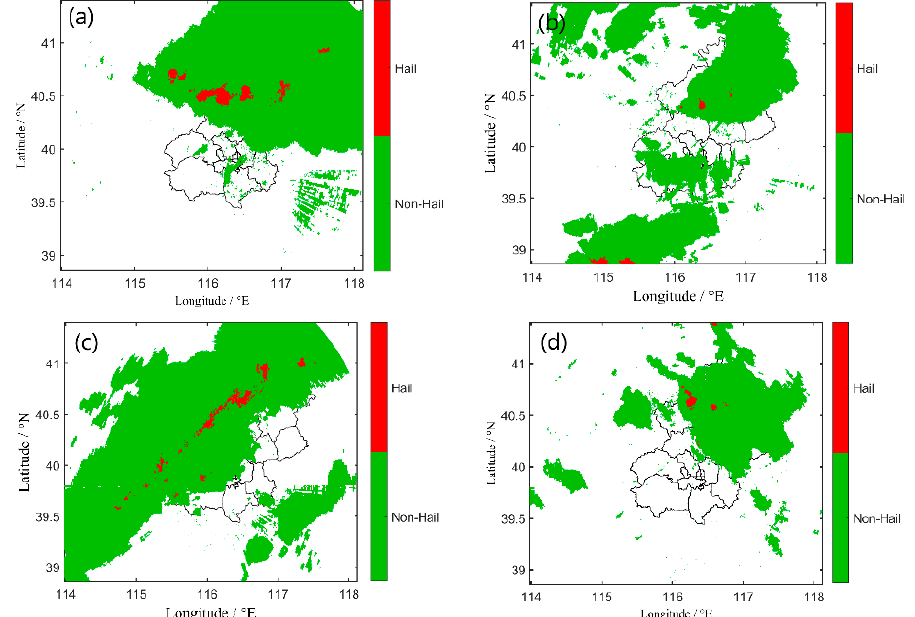
Figure 8. Hail − bearing locations according to radar data from Beijing. ( a ) Hail − bearing locations from the radar at 20:00 BJT on 25 June 2021; ( b ) hail − bearing locations from the radar at 16:00 BJT on 30 June 2021; ( c ) hail − bearing locations from the radar at 16:00 BJT on 1 July 2021; ( d ) hail − bearing locations from the radar at 17:00 BJT on 9 August 2021.